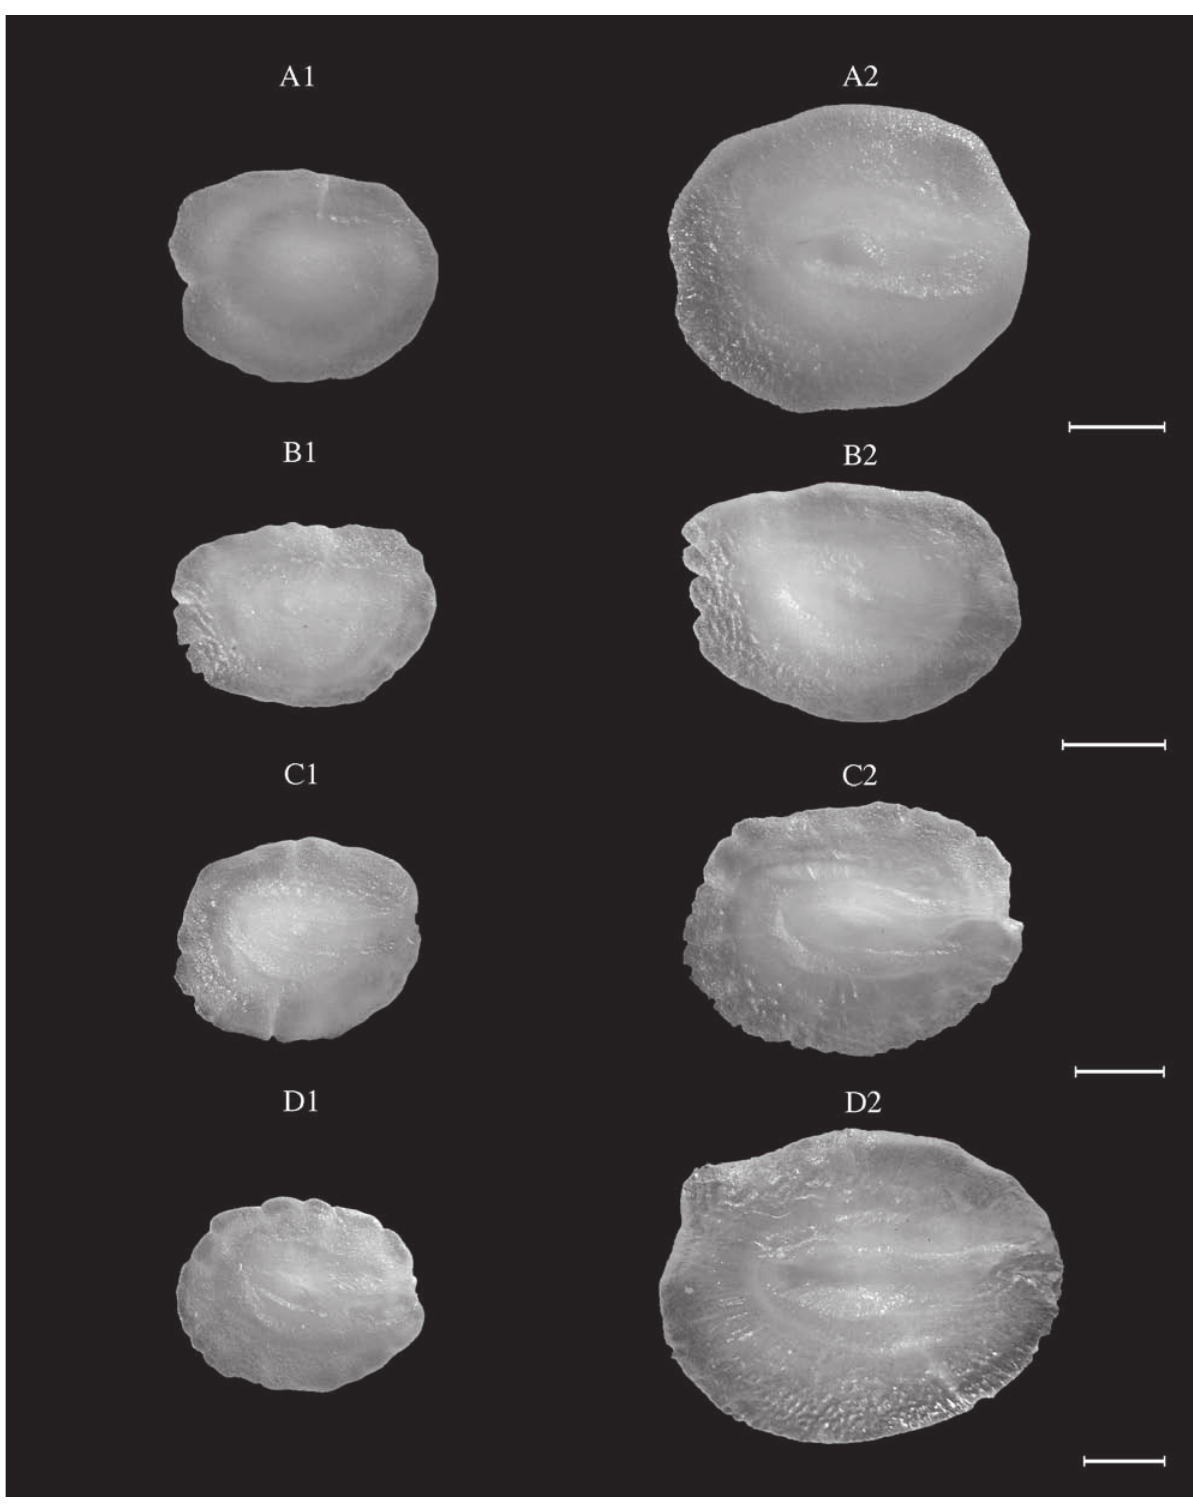
Fig. 91. – Buglossidium luteum (NEA) . TL: A1, 12.4 cm; A2, 17.2 cm. Dicologlossa cuneata (NEA) . TL: B1, 12.6 cm; B2, 19.2 cm. Dicologlossa hexophthalma (NEA) . TL: C1, 13.1 cm; C2, 19.1 cm. Microchirus azevia . TL: D1, 14.8 (NEA) cm; D2, 26.7 cm (CEA). Scale bar = 1